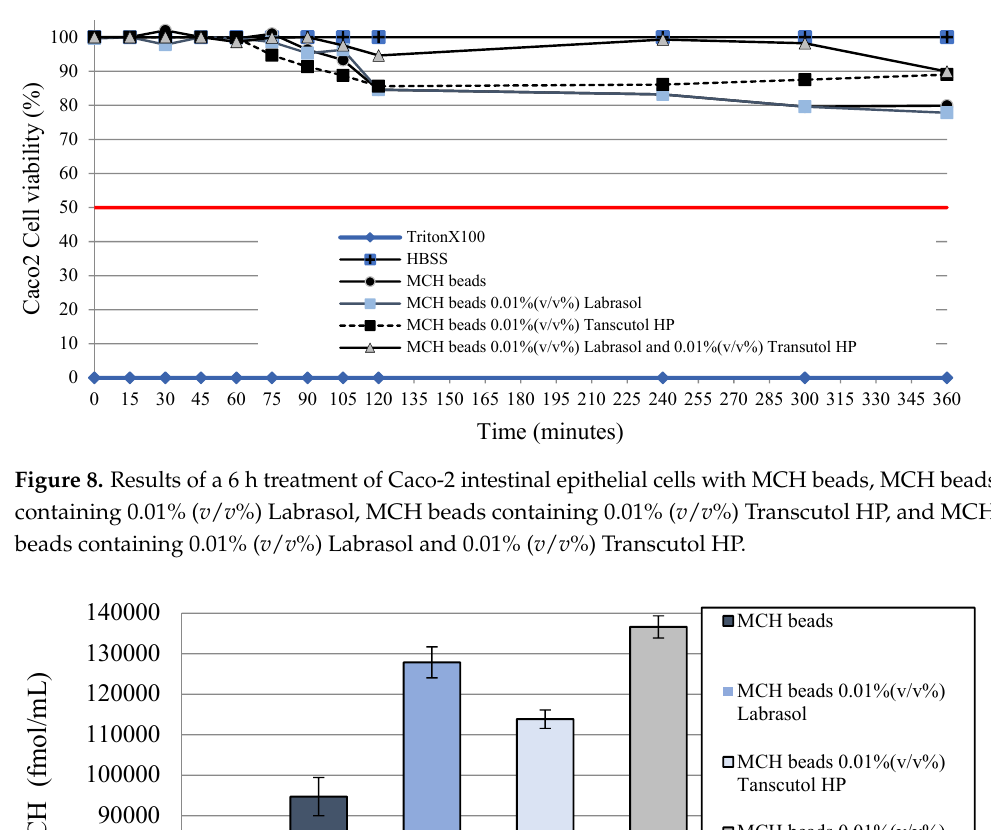
containing 0.01% ( v / v %) Labrasol, MCH beads containing 0.01% ( v / v %) Transcutol HP, and MCH beads containing 0.01% ( v / v %) Labrasol and 0.01% ( v / v %) Transcutol HP.